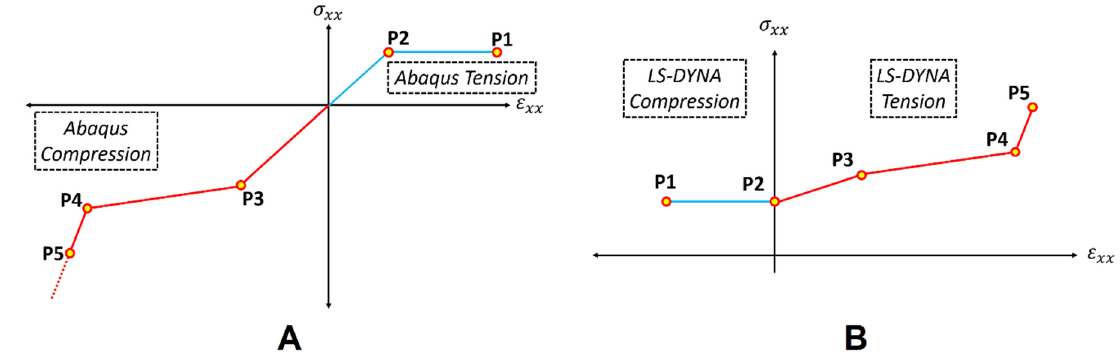
Figure 14. Stress–strain characteristics for Abaqus ( A ) and LS-DYNA ( B ). The Points P1 through P5 are taken from the Abaqus model and translated to the LS-DYNA model. P2, which has a non-zero strain in Abaqus, has to be shifted to zero strain. The excluded part represents the elastic part of the characteristic, which is not included in the LS-DYNA load curve but defined separately by Youngs’ modulus.